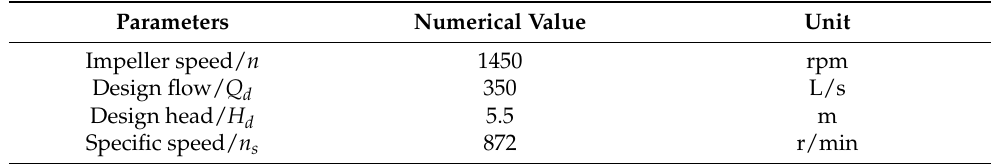
Table 1. Axial flow pump design parameters.